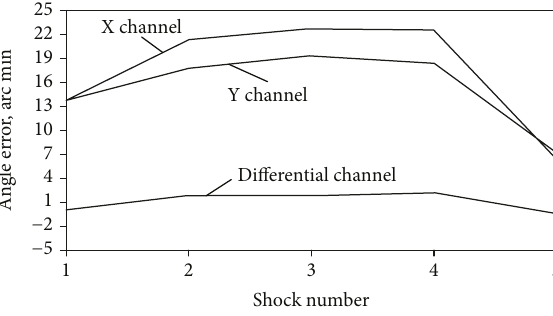
Figure 5: Angle errors during fi ve 20 g shocks along